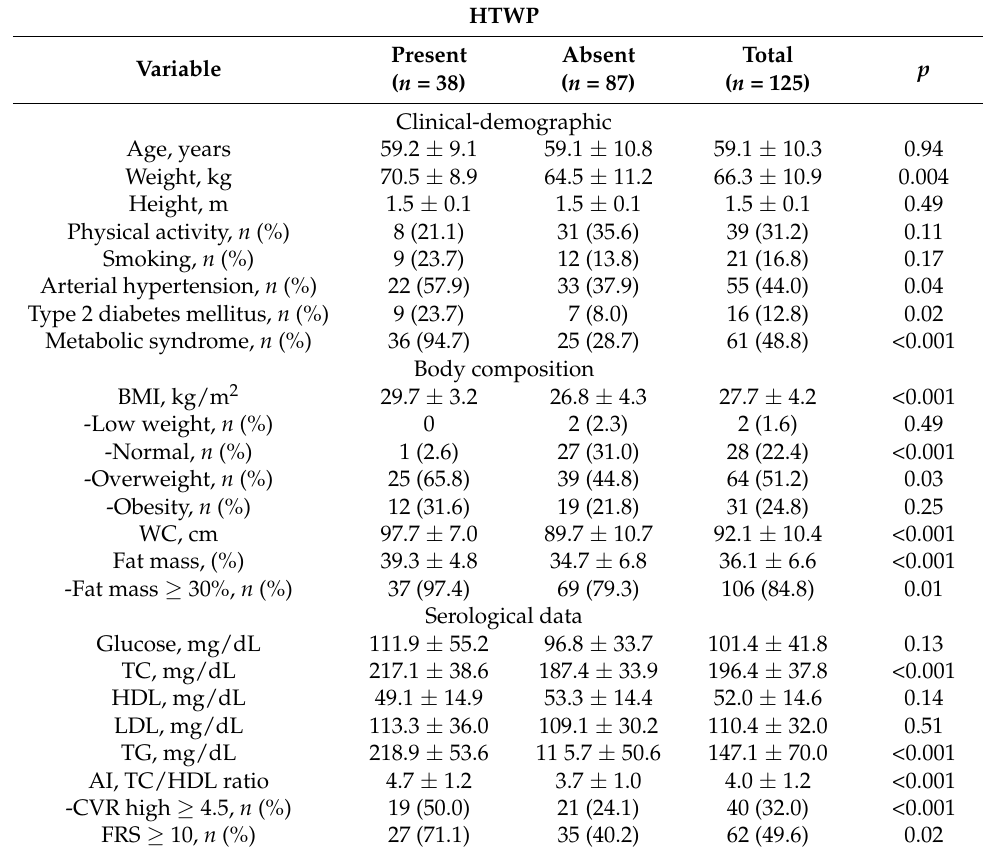
Table 1. Comparison of general characteristics according to the hypertriglyceridemic waist phenotype in 125 women with rheumatoid arthritis.